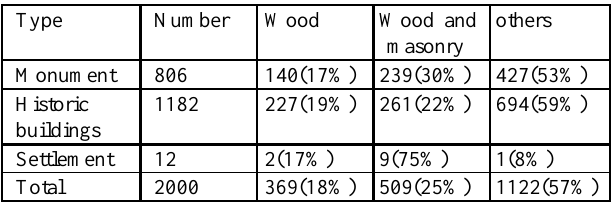
Table 1. CH in Taiwan